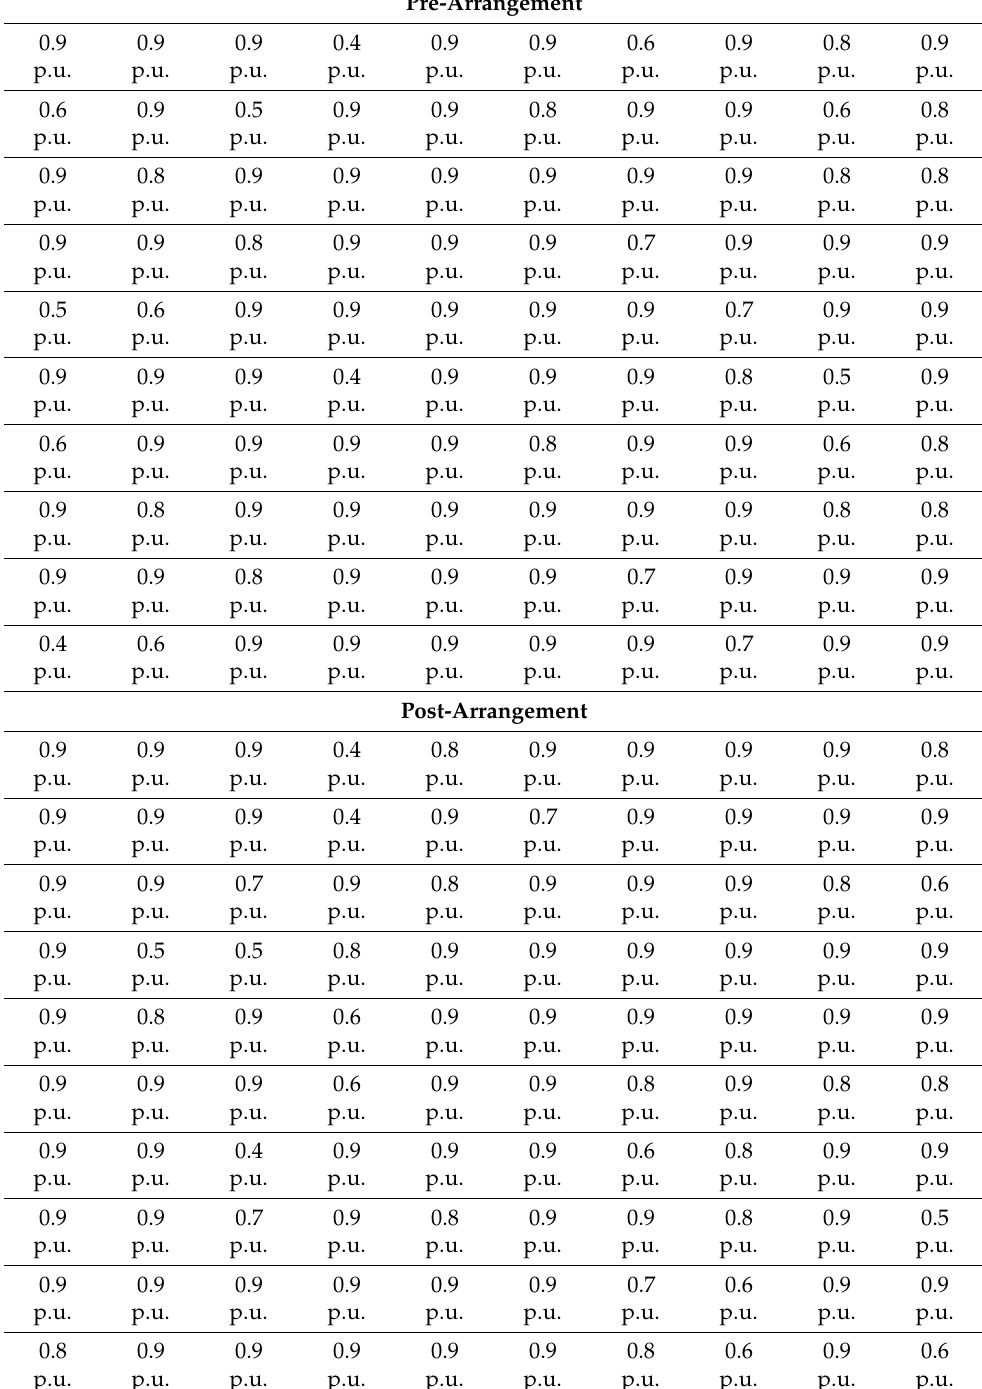
Table 5. The parameters associated with the two types of 10 × 10 PV arrays (i.e., 18-kW and 43-kW) after application of reconfiguration in 14 different